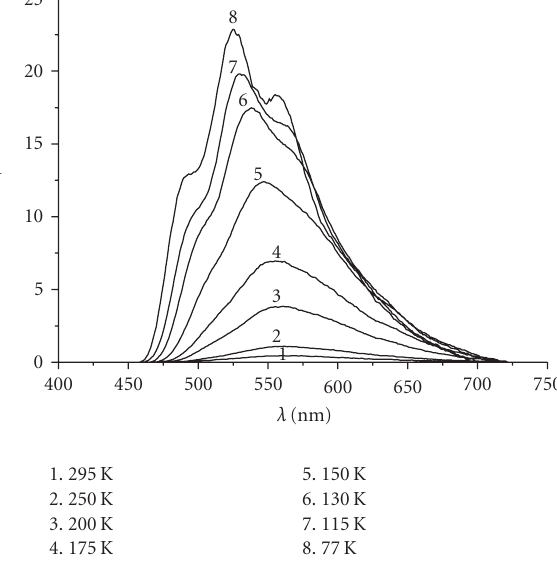
Figure 3: The fluorescence spectra of II in ethanol at di ff erent tem- peratures.